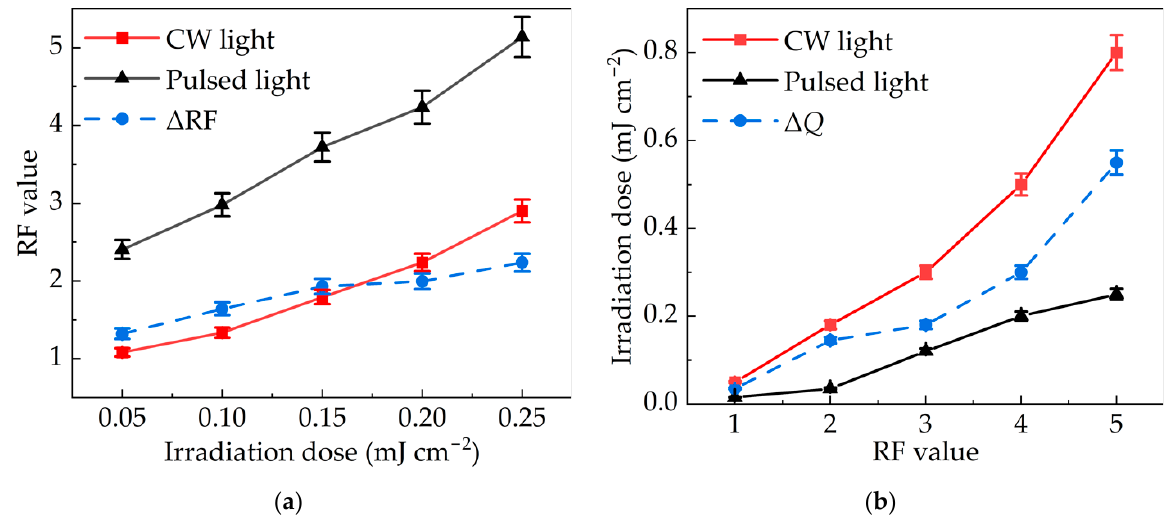
Figure 6. Comparison of inactivation effects between pulsed light and CW light: ( a ) RF value under the same irradiation dose and ( b ) dose required under the same RF value.